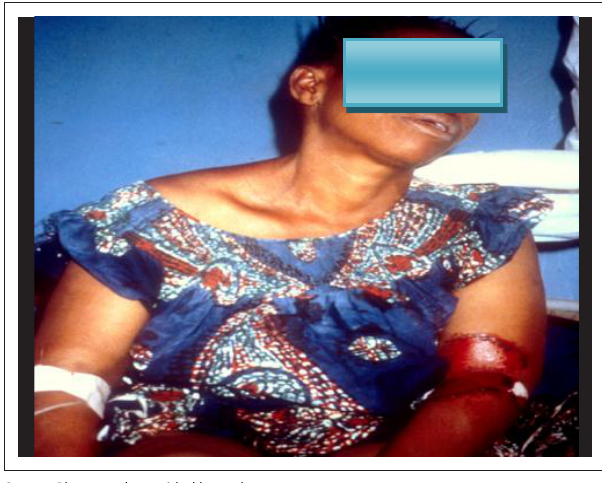
FIGURE 5: Ebola patient with haemorrhagic diathesis at transfusion and injection